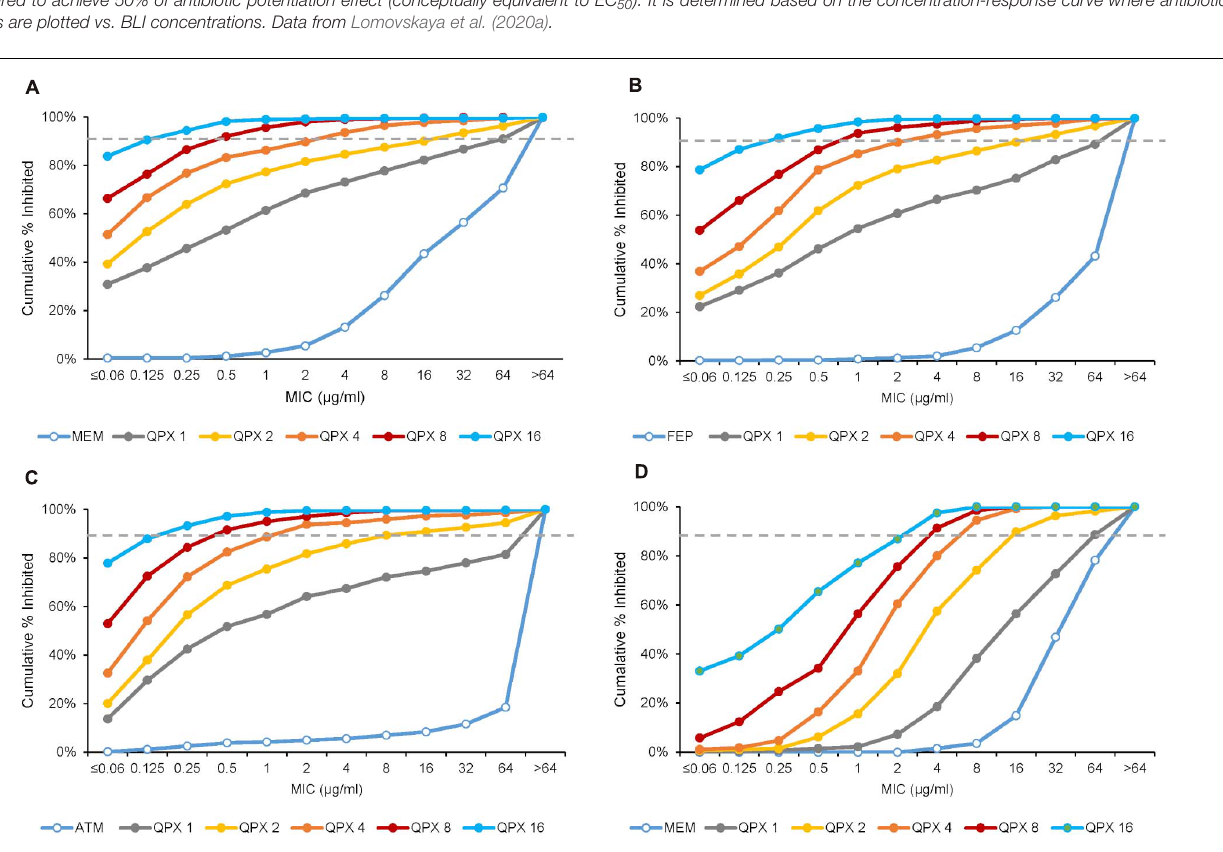
FIGURE 6 | MIC distributions of various antibiotics with increasing concentrations of QPX7728 against ESBL and carbapenemase-producing Enterobacterales (A–C) and carbapenem-resistant Acinetobacter baumannii (D) . (A) Meropenem alone and with QPX7728 tested against the panel of 598 CRE isolates that contained 285 KPC, 39 OXA-48, 50 non-carbapenemase-producing CRE and 224 MBL-producing strains (149 NDM, 51 VIM, 19 IMP). (B) Cefepime or aztreonam (C) alone and in combination with QPX7728 tested against the panel of 756 strains of Enterobacterales with characterized β -lactamases; in addition to class A ESBLs and various class C enzymes it contained 302 KPC (9 in combination with MBLs), 70 OXA-48-like and 224 MBLs. (D) Meropenem alone and with QPX7728 tested against the panel of 275 carbapenem-resistant strains of A. baumannii . Figures are constructed based on data in Nelson et al. (2020a;